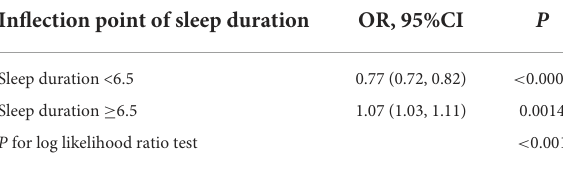
TABLE 3 The result of two-piecewise linear regression